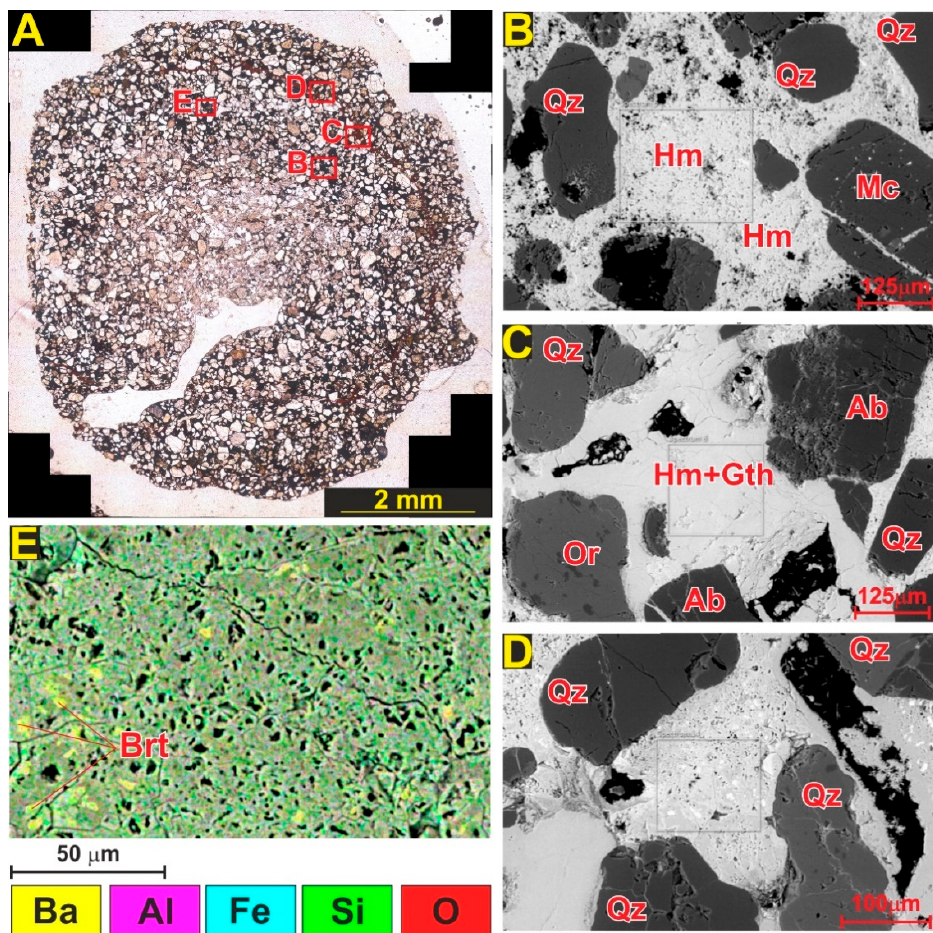
Figure 14. BSE images and elemental mapping of selected areas in core and shell section of fulgurite samples. ( A ) SEM-BSE and SEM-EDX analysis location on fulgurite sample. SEM-BSE images of the core ( B ), and shell sections ( C , D ). SEM-EDX mapping on the core section ( E ) of fulgurite. Abbrevi-